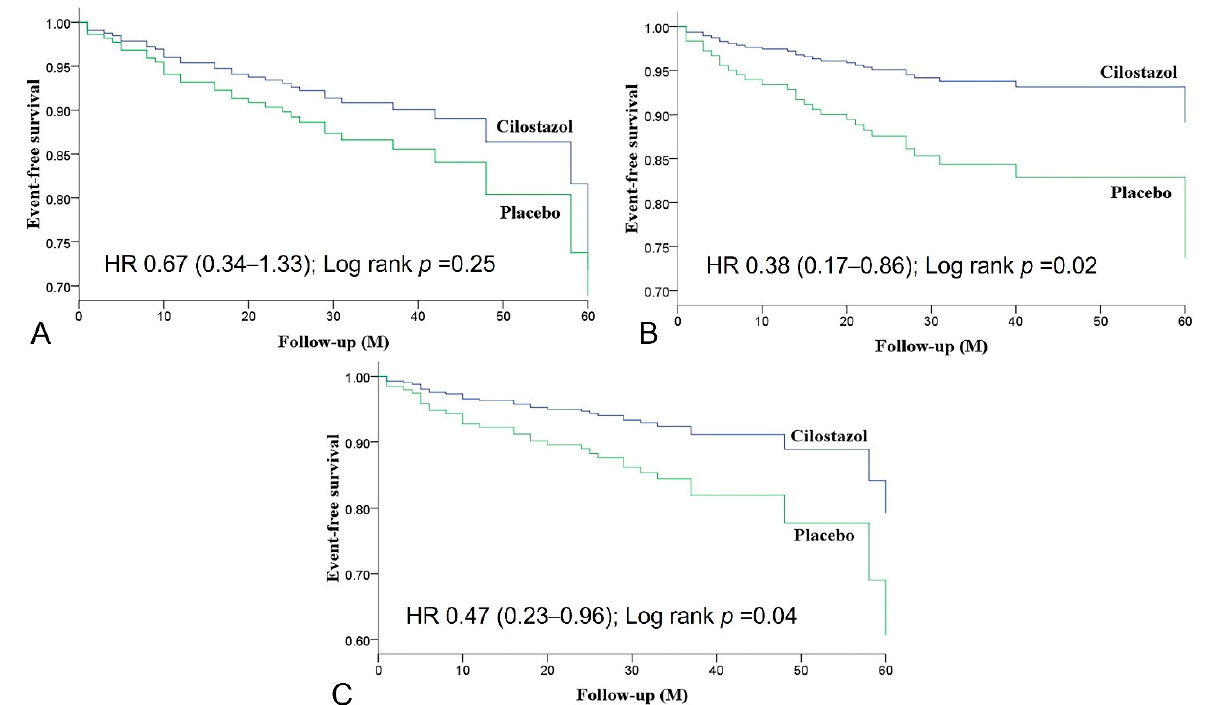
Figure 2. Event-free survival of the composite endpoints stratified by cilostazol or placebo use by Kaplan–Meier analysis using the log-rank test. ( A ) Major adverse cardiovascular events; ( B ) Major coronary events; ( C ) Major adverse cardiovascular and cerebrovascular events. HR, hazard ratio; M, months. Table 3. Uni- and multi-variables independently predicting major coronary